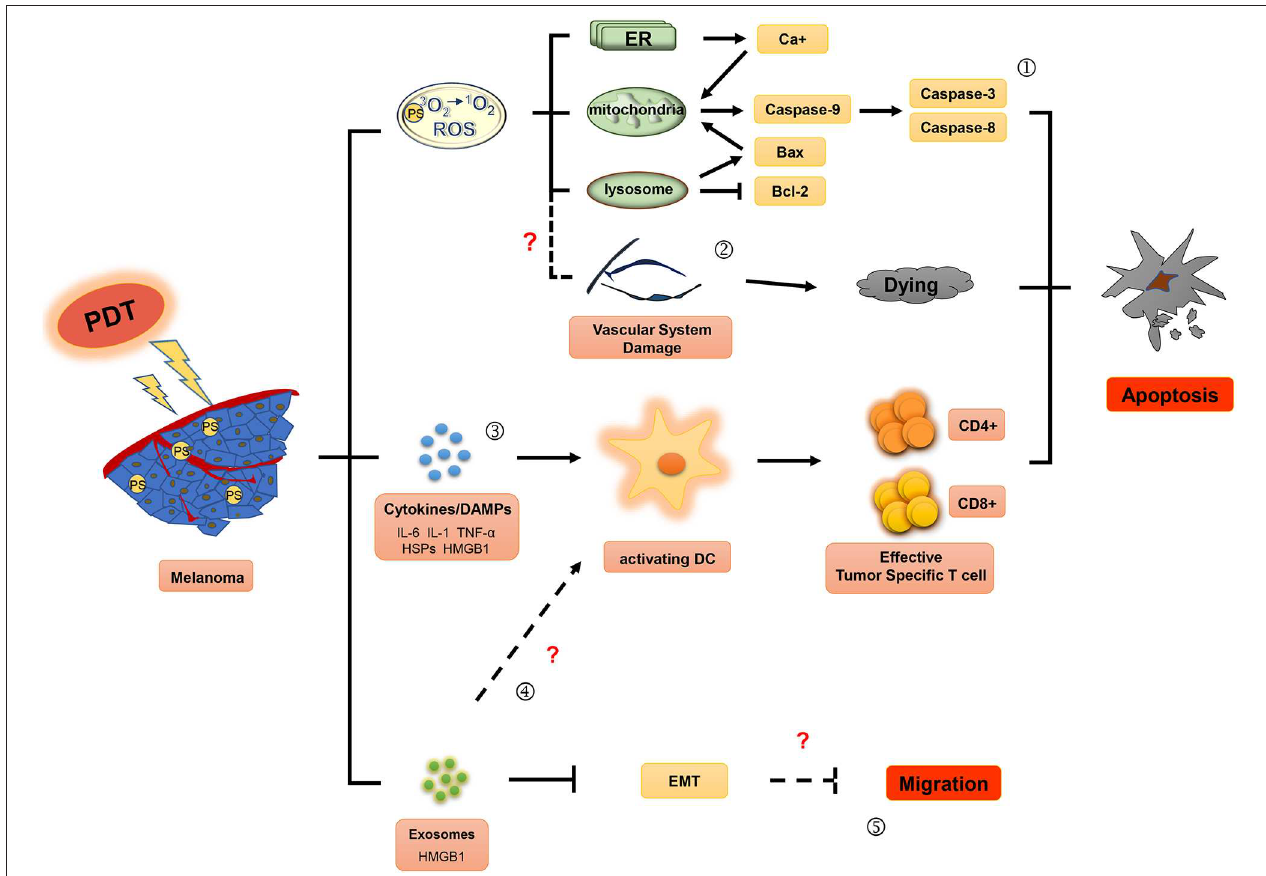
FIGURE 1 | Effector mechanisms during photodynamic therapy of melanoma. The ground state photosensitizer (PS) is activated by irradiation with appropriate wavelength light to produce singlet state. Reactive oxygen species (ROS), the main cytotoxic components, can cause death of tumor cells by apoptosis ( ‹ ) and induce the damage of the tumor vascular system ( › ). In addition, photodynamic therapy may also activate immune responses against tumors by affecting the secretion of inflammatory factor (IL-6, IL-1, and TNF- α ), HSPs (heat shock proteins) and DAMPs (damage associated molecular patterns) ( fi ), and exosomes ( fl ). Moreover, exosomes induced by photodynamic therapy (PDT) might play an important role in inhibitory regulation of EMT (epithelial-mesenchymal transition) in melanoma cells ( (cid:176)